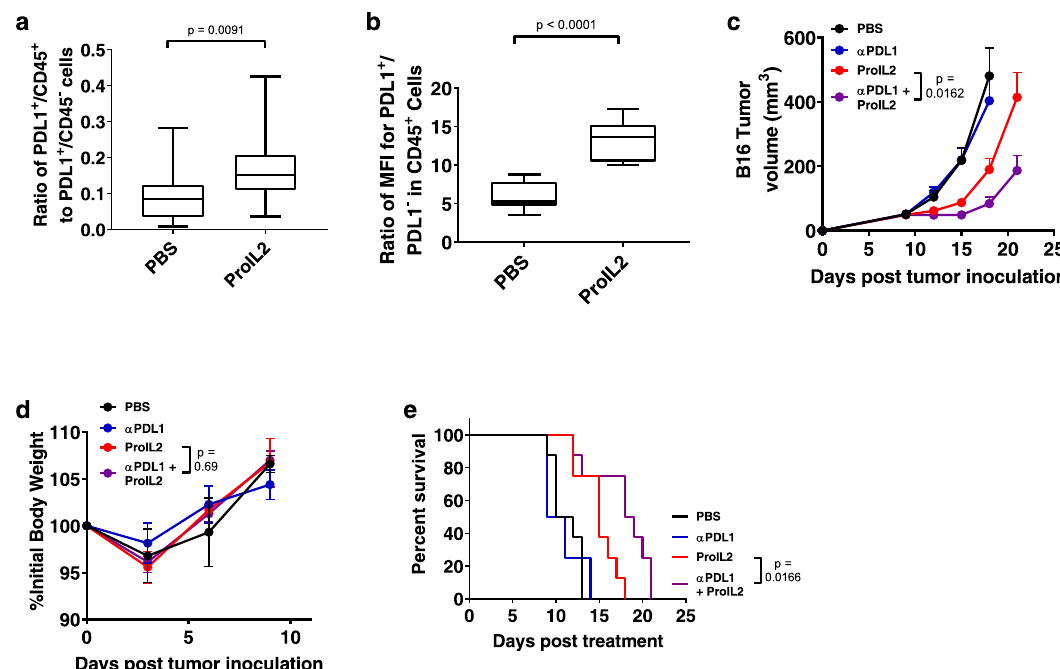
Fig. 6 ProIL2 can overcome tumor resistance to ICB. a , b B16 s.c. tumor-bearing mice were injected i.p. with PBS or ProIL2 (300 pmol) one time on day 9 post tumor inoculation. 72 h after treatment, mice were euthanized and tumors were extracted, digested in collagenase/DNAse, and resuspended as single cells. Flow cytometry was used to quantify the amount of PDL1 + and CD45 + cells. In CD45 + cells, the MFI of PDL1 + and PDL1- cells were compared. Box and whisker plots with maxima, 75th percentile, center, 25th percentile, and minima are displayed ( n = 3 experiments, total 12 individual mice per group). c , d B16 s.c. tumor-bearing mice were injected i.p. with PBS, anti-PDL1 (200 μ g each), ProIL2 (300 pmol), or anti-PDL1 and ProIL2 one time on day 9 post tumor inoculation; tumor growth and body weight were measured ( n = 3 experiments, total 12 individual mice for PBS and ProIL2 treatment groups, 13 for anti-PDL1 and combination groups). e Mice were analyzed for survival starting the day after treatment. For mouse health, mice were euthanized when tumors reached a volume of greater than 1000 mm 3 ( n = 2 experiments, total 8 individual mice per group). Data represent mean ± s.e.m. Student ’ s t tests ( a – d ) or log-rank tests ( e ) were performed to calculate p values. Source data are provided as a Source Data fi